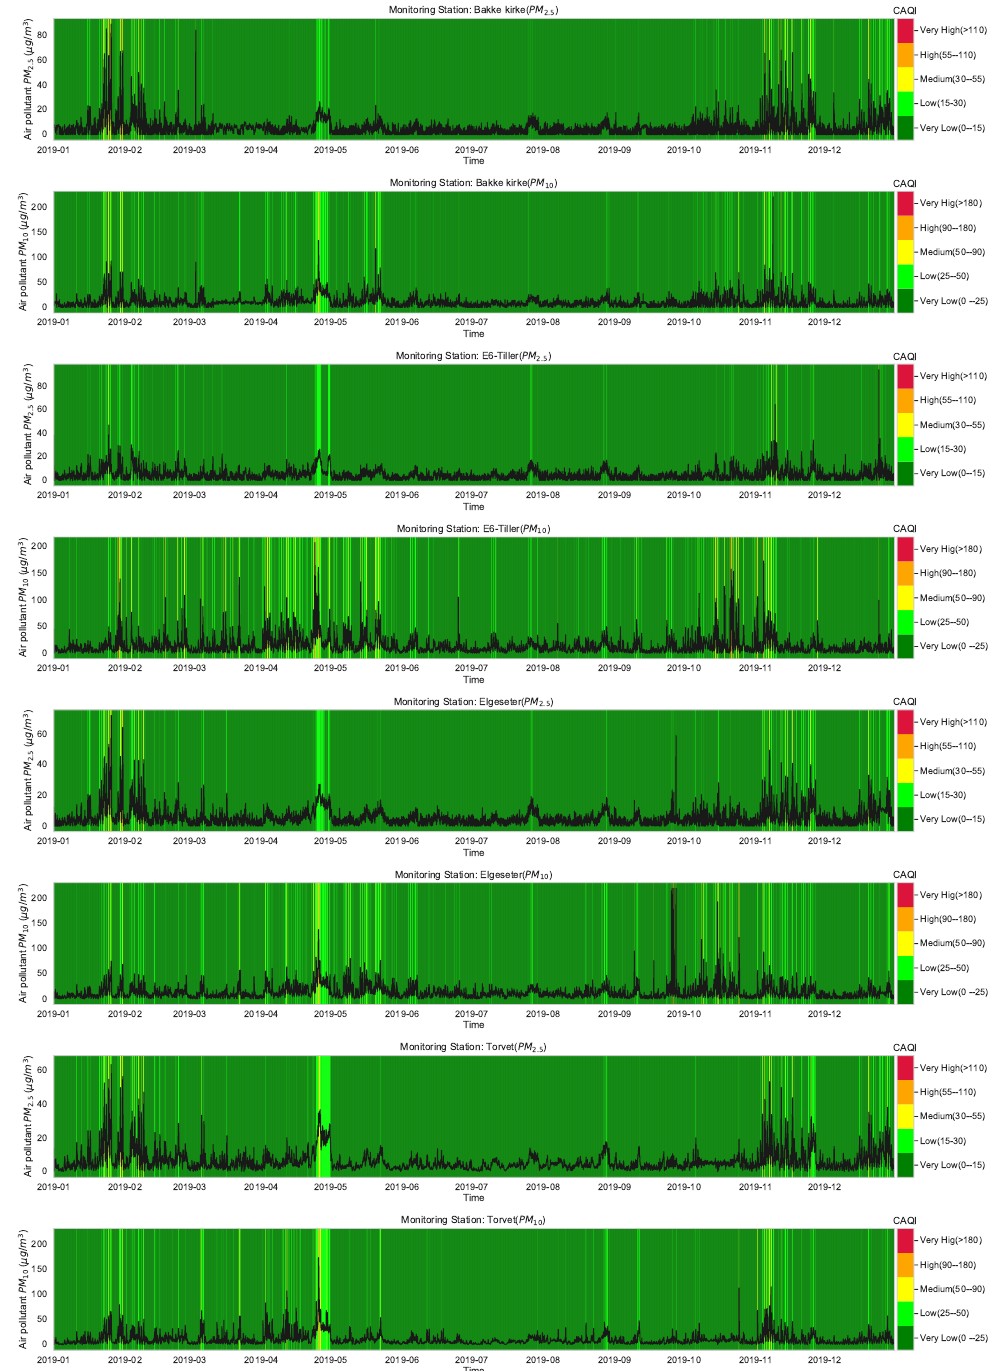
Figure A8. Air quality in the city of Trondheim over one year in all monitoring stations. The data are decomposed into the five CAQI levels of air pollutants. It is usually at Very Low and rarely exceeds the Medium